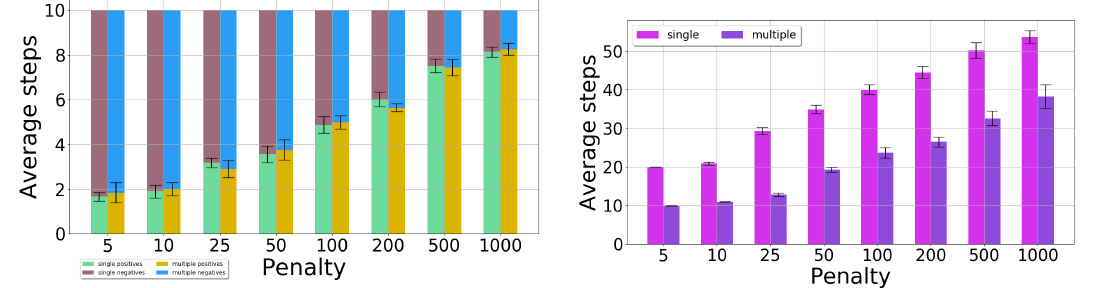
Figure 12. Comparisonbetweenthesingle-andmultiple-observationexperiments:Countofpositive/negative classifications ( left ) and number of steps needed for sorting ( right ).